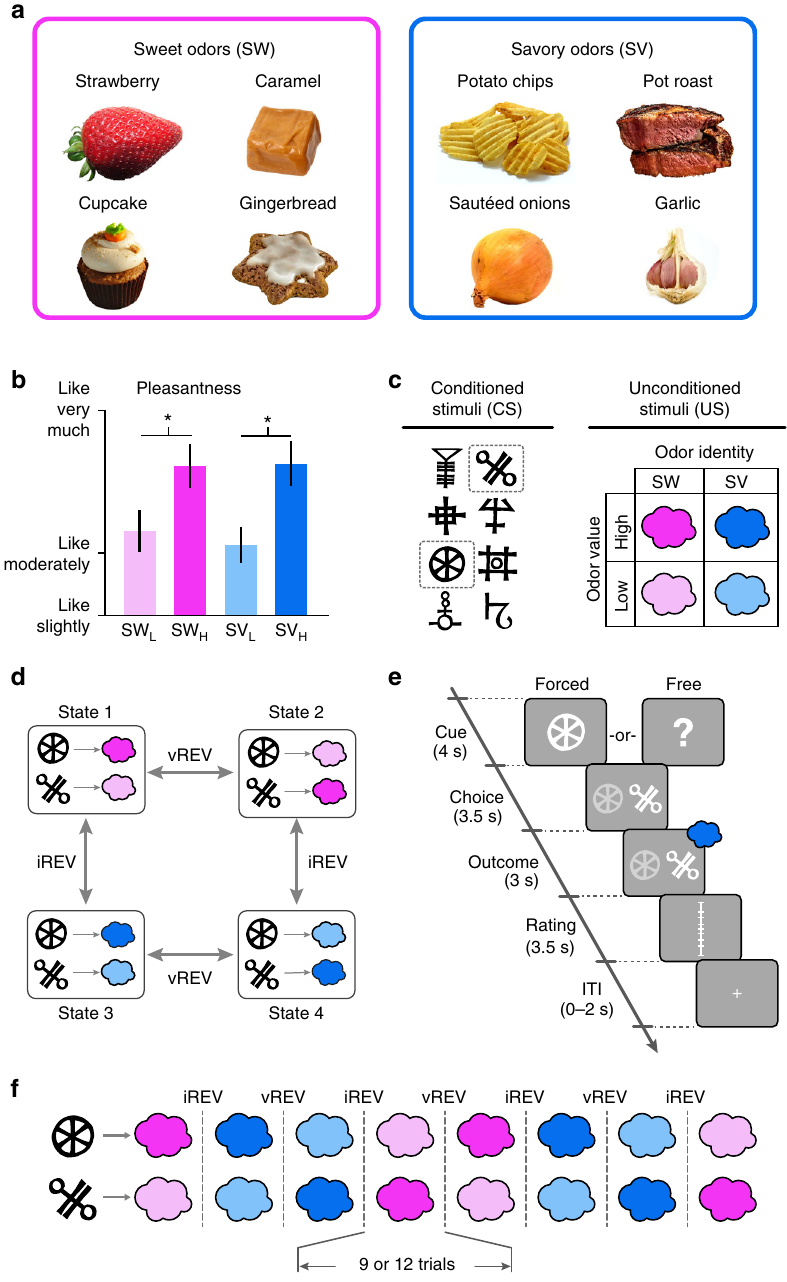
Fig. 1 Odor selection and transreinforcer reversal learning task. a From an initial set of eight food odors, one sweet (SW) and one savory (SV) odor was chosen for each participant ( n = 23) such that they were matched in rated pleasantness. A high-intensity and low-intensity version of each selected odor was then established. b High-intensity odors (SW H , SV H ) were rated as more pleasant than low-intensity odors (SW L , SV L ), and matched in pleasantness within intensity level. Error bars depict within-subject s.e.m. * p < 0.05 in post-hoc paired t -tests. c Two visual symbols (randomly selected for each participant) were used as conditioned stimuli (CS). The four food odors, comprising a 2 × 2 factorial design with value and identity as factors, were used as unconditioned stimuli (US). d Speci fi c CS – US associations conformed to four unique states in the reversal learning task. Transitions between states followed either identity reversals (iREV) or value reversals (vREV). e On each trial, participants fi rst saw a pre-choice “ cue ” to indicate whether it was a forced-choice or free-choice trial. They then chose one of the two CS ’ s to receive its deterministically paired odor US. f A given state persisted for either 9 or 12 trials, and states were separated by iREV or vREV. An 84-trial sequence for one example fMRI run is depicted. Participants completed three fMRI z = 0.48, one-sample t -test, t (22) = 6.04, p = 4.46 × 10 − 6 ). Model- vPE, and negative vPE (based on prior studies demonstrating that positive and negative value PE ’ s are processed in dissociable brain derived PE ’ s were included as parametric modulators of fi nite regions 30,31 , the vPE trace was split into positive and negative impulse response functions (FIR) time-locked to the onset of the components). As can be seen in Fig. 2c, this model accounted well US ’ s, and regressed against the fMRI responses in each voxel (see for choice behavior (average Fisher ’ s z -transformed correlation Methods section). between model-predicted and actual choice behavior across trials,